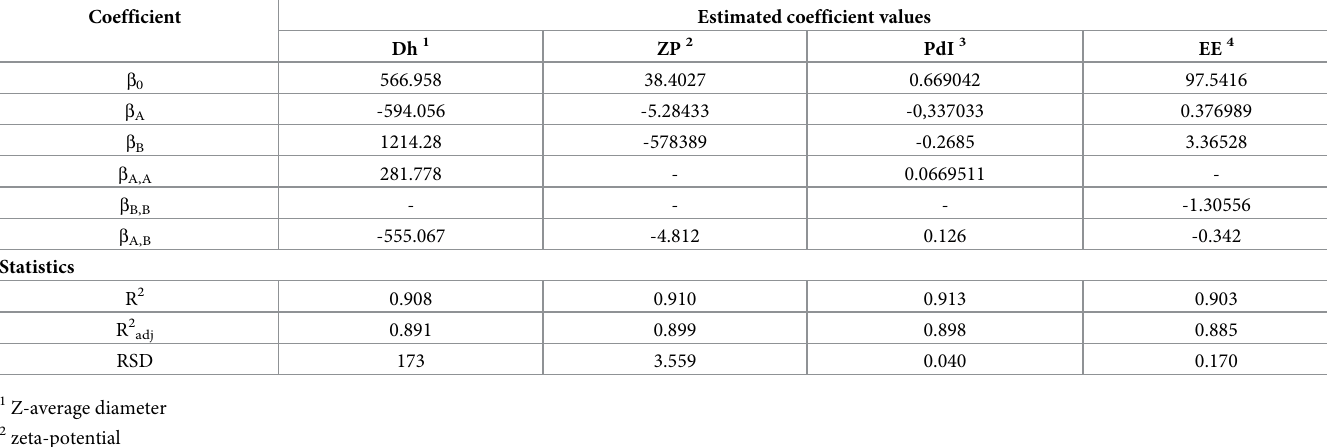
Table 3. Estimates of the coefficients of each term in the recalculated model and the corresponding statistics.